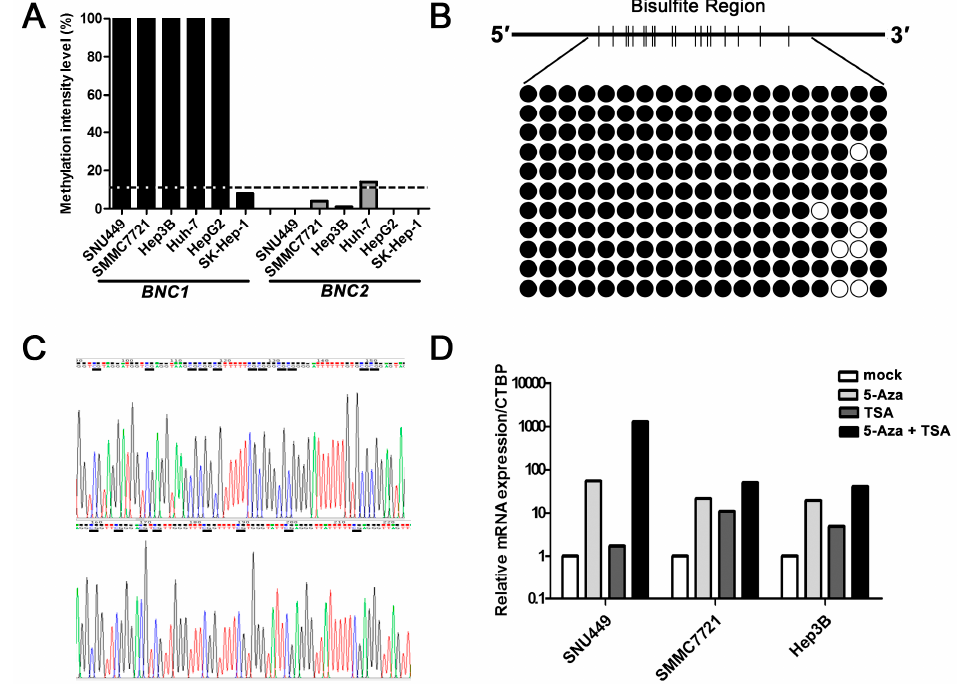
Figure 3. Promoter methylation status of BNC1 and BNC2 in liver cancer cell lines. ( A ) The methylation status of BNC1 and BNC2 genes in five HCC cell lines and liver adenocarcinoma cell line SK-Hep-1 detected by methylation-sensitive restriction enzymes-based quantitative PCR (MSRE-qPCR). The dotted line represents the 10% cut off value; ( B ) Bisulfite sequencing analysis of the BNC1 CpG island in Hep3B cells. Short vertical bars represent CG sites; black circles represent methylated CG sites; white circles represent unmethylated CG sites; ( C ) A representative bisulfite sequencing chromatogram of BNC1 CpG island in Hep3B cells. The green lines represent adenine “A”, blue lines represent cytosine “C”, black lines represent guanine “G” and red lines represent thymine “T”; ( D ) BNC1 expression in three HCC cell lines after treatment with 5-Aza-2 ′ -Deoxycytidine, trichostatin A (TSA) or both. The mock group was normalized as 1.